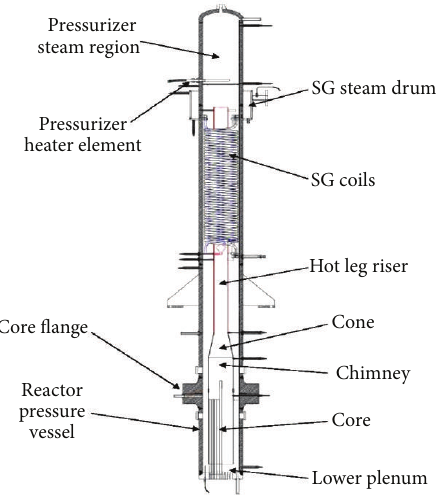
Figure 2: Layout of reactor pressure vessel: OSU-MASLWR